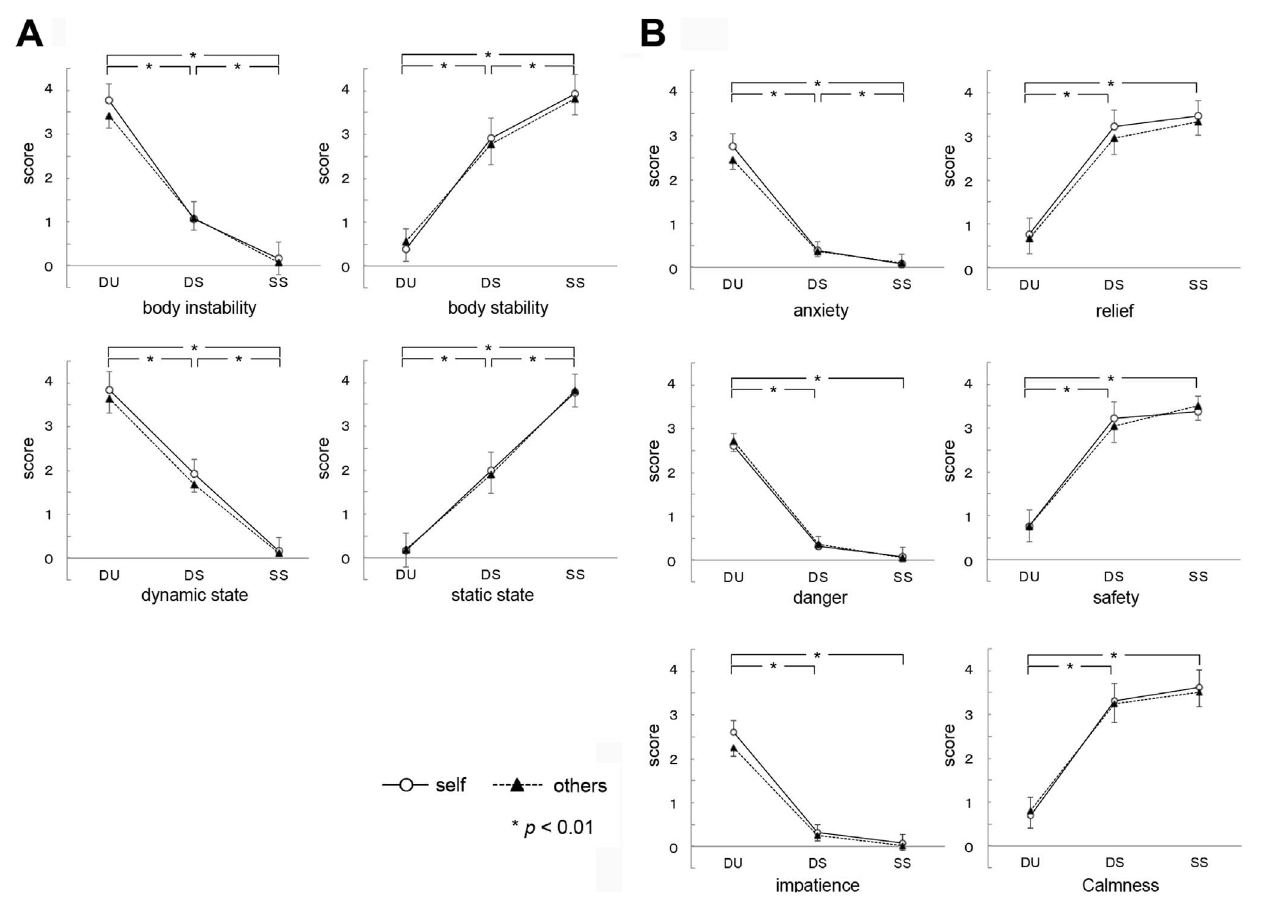
Fig. 2. Subjective ratings of motion pattern (A) and emotion (B). There were significant main effects of conditions (DU, DS, and SS), and no significant main effects of performers. DU: dynamically unstable, DS: dynamically stable, SS: statically